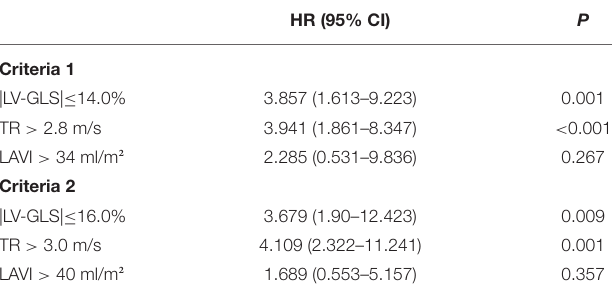
TABLE 4 | Prognostic values of LV-GLS with conventional echocardiographic parameters for adverse outcomes by cox proportional hazard regression multivariate analysis according to different cut off